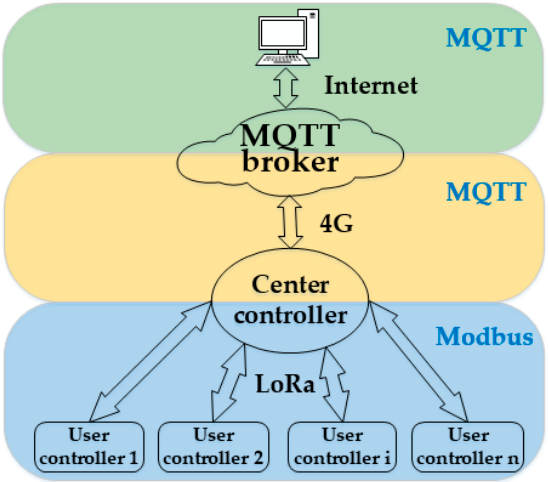
Figure 10. Wireless communication framework.